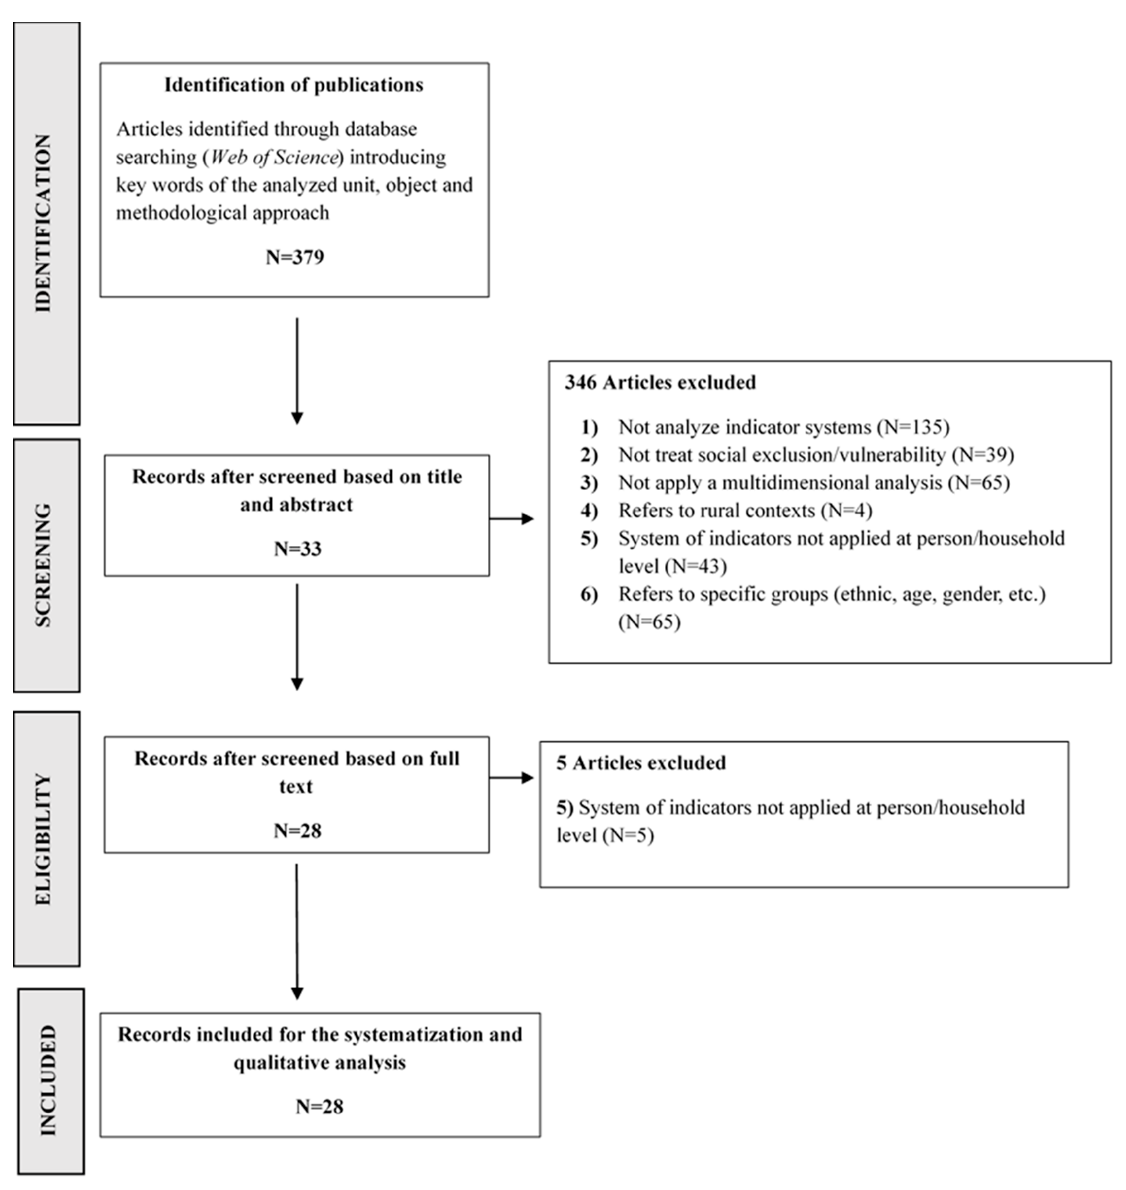
Figure 1. Flow diagram of study selection.